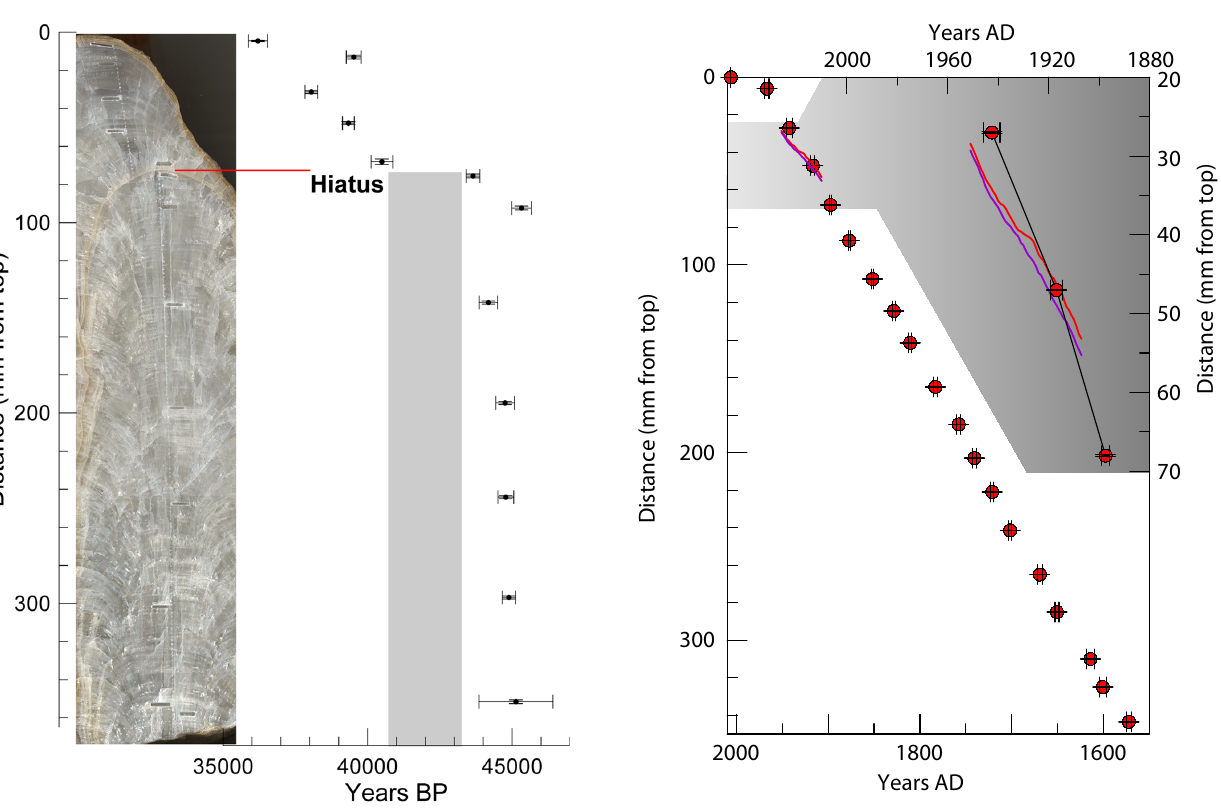
Fig. 4. Depth-age diagram of TSAL-1: the U-series dates that are included in this example are shown in black. A hiatus is clearly visible in the scan. This hiatus should be treated by splitting the age model into two segments.